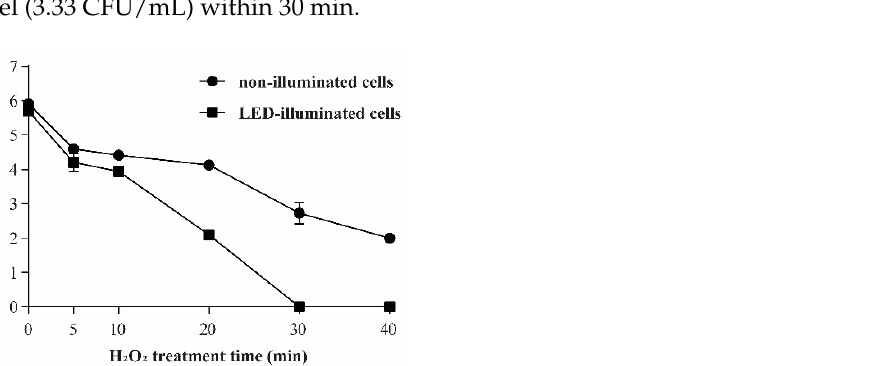
Figure 6. Survival of S . Typhimurium in simulated gastric fluid (SGF) at pH 3 ( A ) and pH 2 ( B ). ( ● ) non-illuminated cells, ( ■ ) 405 nm LED-illuminated cells. 3.3.5. Resistance of S . Typhimurium to Bile Salts Figure 7 shows the population of LED-illuminated and non-illuminated S . Typhi- murium after treatment with different concentrations of bile salts. The initial populations of non-illuminated cells and LED illuminated cells were 5.99 ± 0.07 and 5.82 ± 0.08 log CFU/mL, respectively. After exposure to 1.0% bile salts for 60 min, the population of each group was significantly decreased, by 2.02 and 2.42 log CFU/mL ( p < 0.01), respectively (Figure 7A). A decrease of around 2.07 log CFU/mL was observed for the control after exposure to 2.0% bile salts for 60 min, and the cell population of the LED illuminated